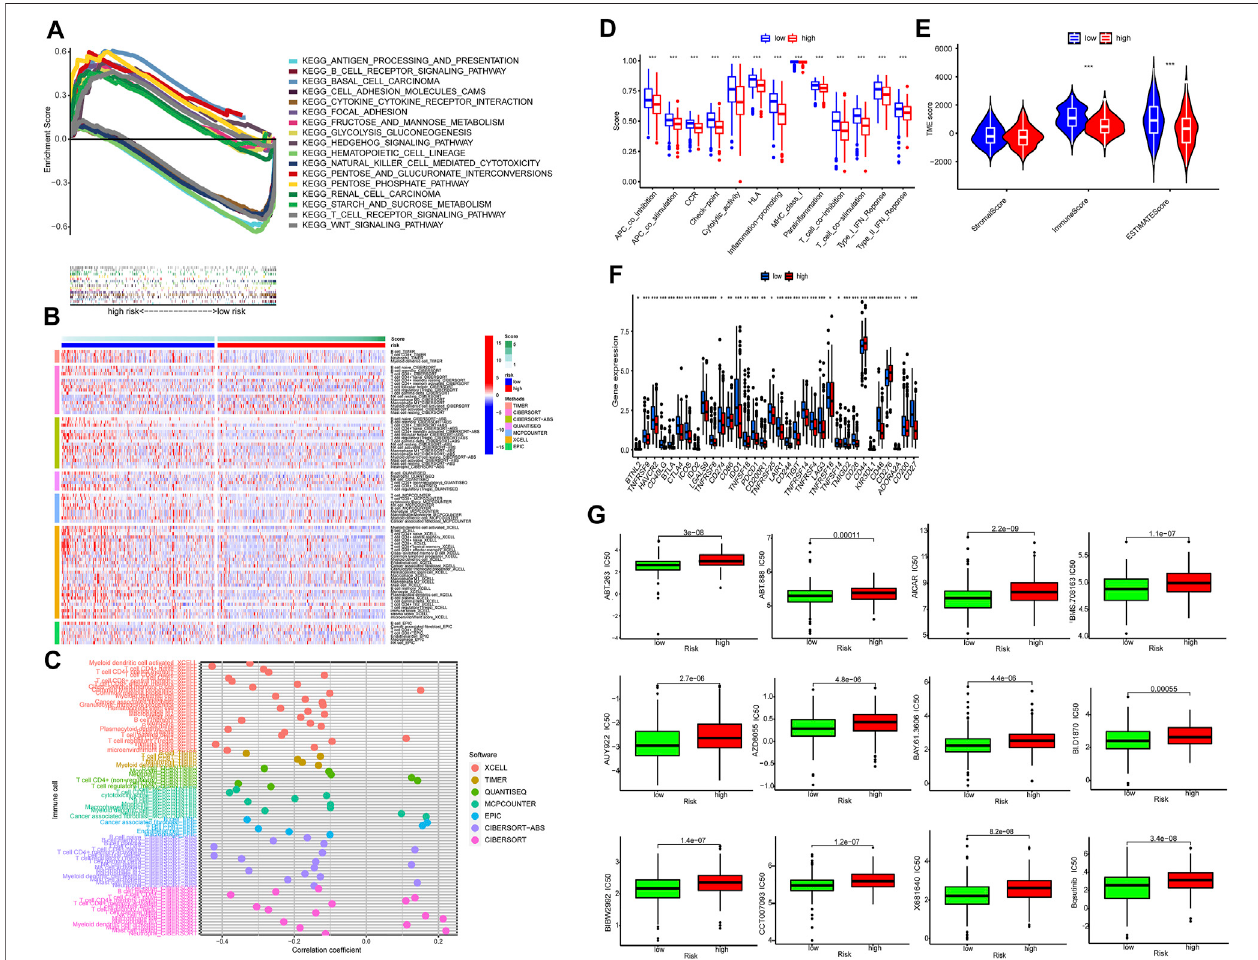
FIGURE 7 | Tumor immune microenvironment. (A) Top 10 pathways by GSEA analysis. (B,C) The heat maps and bubble chart of immune cells. (D) The ssGSEA scores of immune functions of the low-risk group and the high-risk group. (E) The comparison of immune and stromal scores between the low-risk group and the high- riskgroup. (F) Theexpressionof34checkpointsofthelow-riskgroupandthehigh-riskgroup. (G) Twelvetargetedandimmunotherapeuticdrugswithsigni fi cantlylower IC 50 for the low-risk group compared to the high-risk